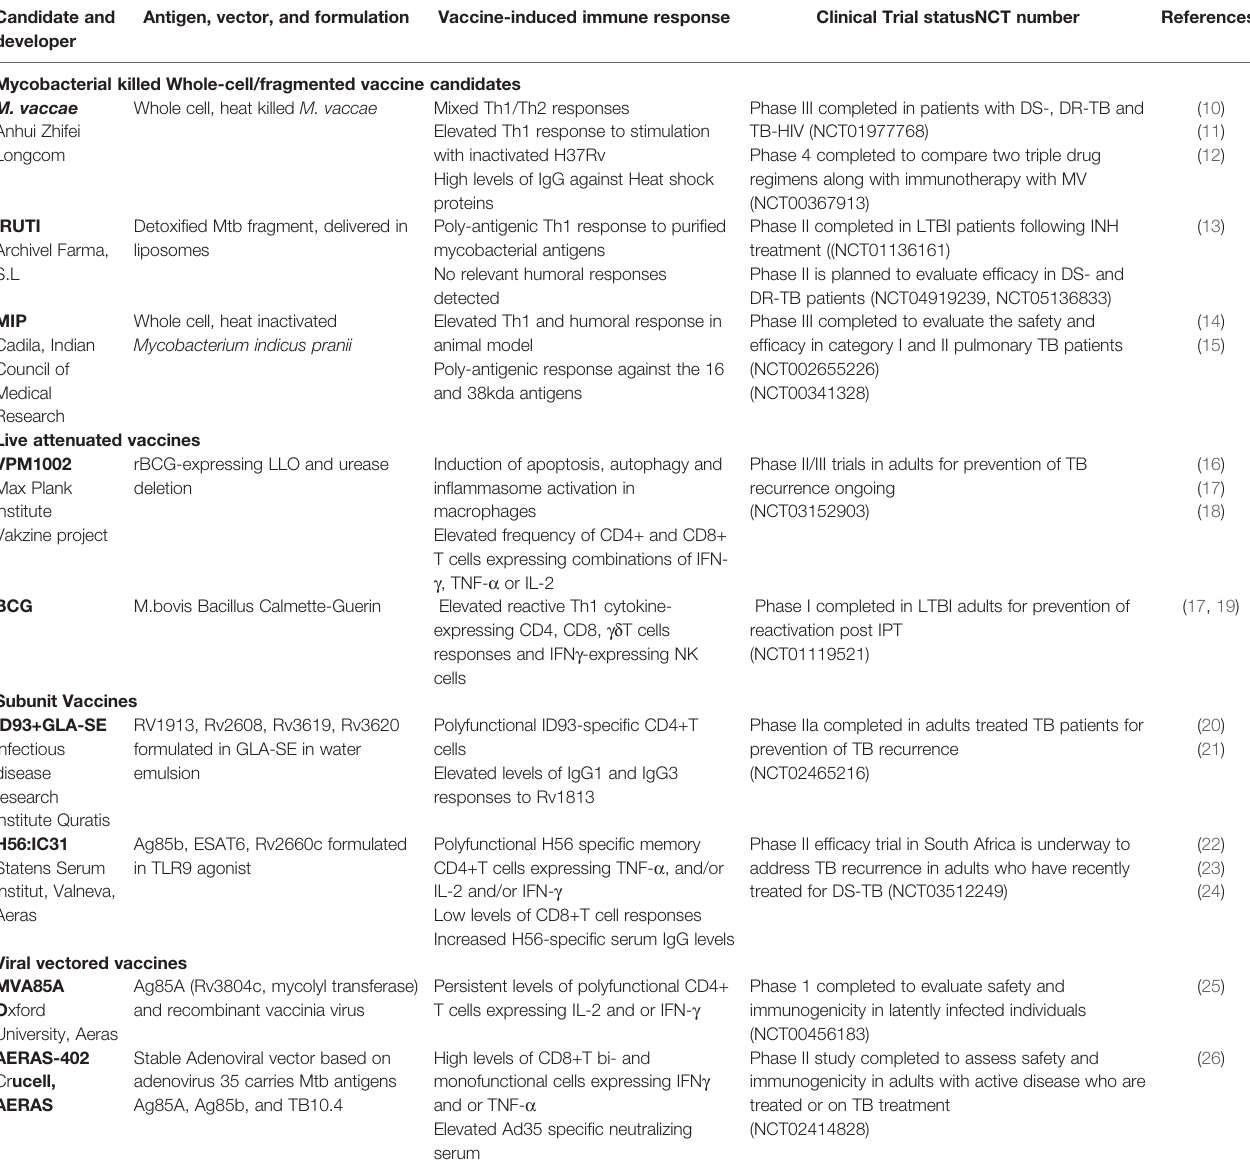
TABLE 1 | Therapeutic vaccines used in clinical